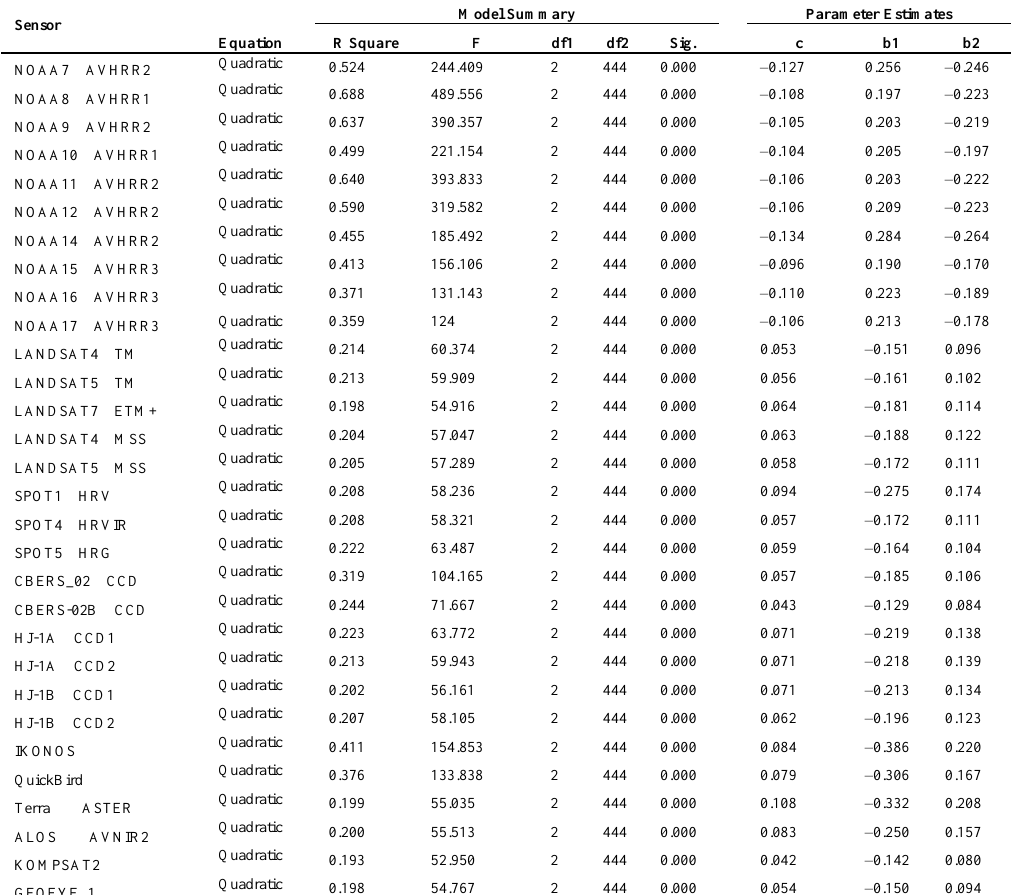
Table 5. Parameters of polynomial fit to the relative spectral correction for simulated reflectance in NIR channel. Equation: y = c + b1 x + b2 x 2 , y denotes RPD in the NIR reflectance, x denotes NDVI for particular